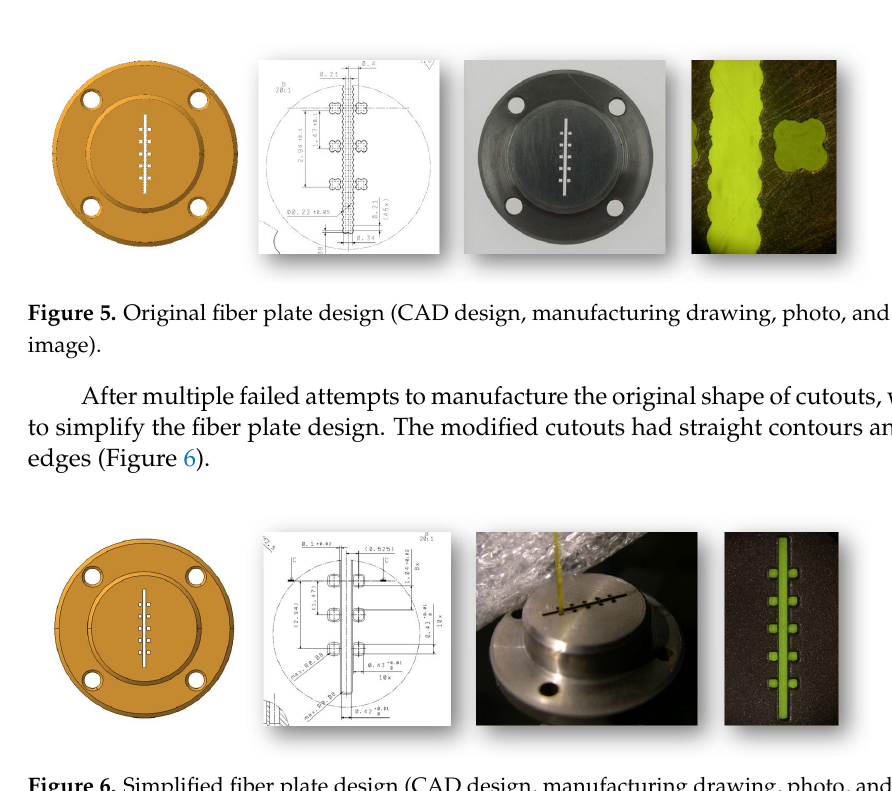
Figure 6. Simplified fiber plate design (CAD design, manufacturing drawing, photo, and microscopy image).